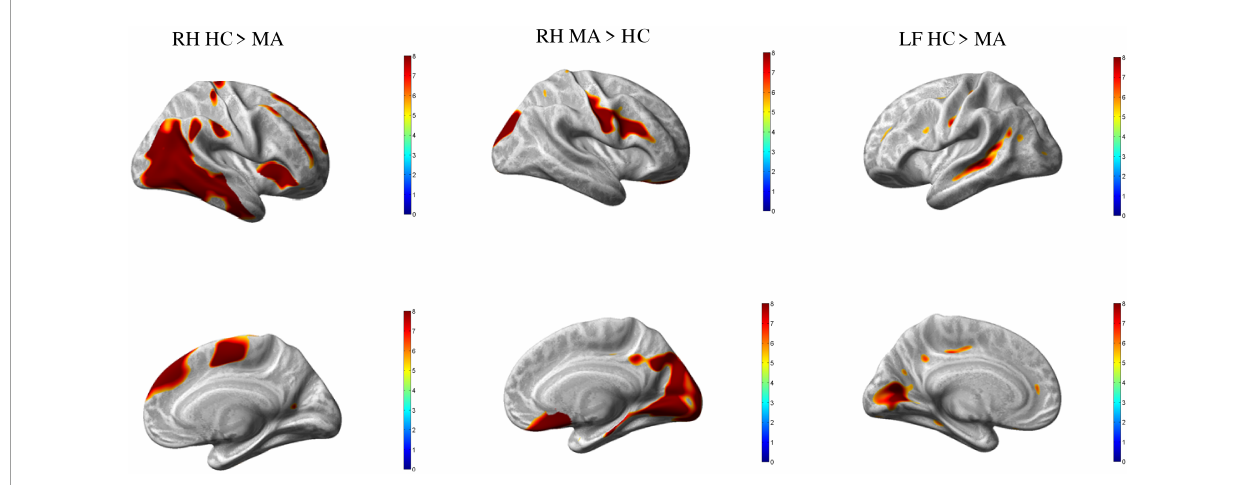
FIGURE1 Group differences healthy controls (HC) vs. MA, p < 0.01 [family wise error (FWE) corrected]. Surface-based statistical maps showing clusters vertices of significant cortical thinning (LH and RH HC > MA) or thicker (RF MA > HC) in patients with pure visual auras (MA).